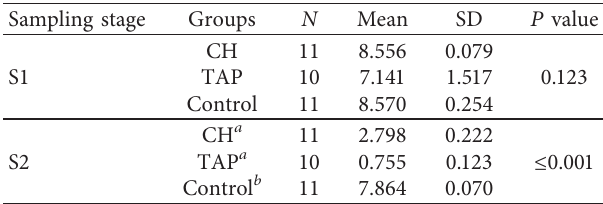
Table 1: Mean and standard deviation of E. faecalis bacteria counts at S1 and S2.